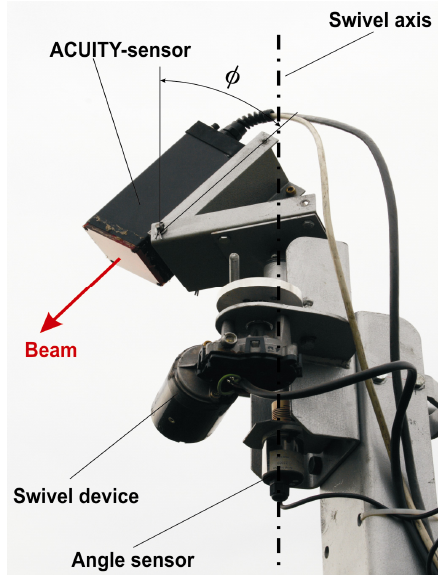
Figure 4. Arrangement of laser rangefinder and swivel drive (vertical axis) for measurements under field conditions.